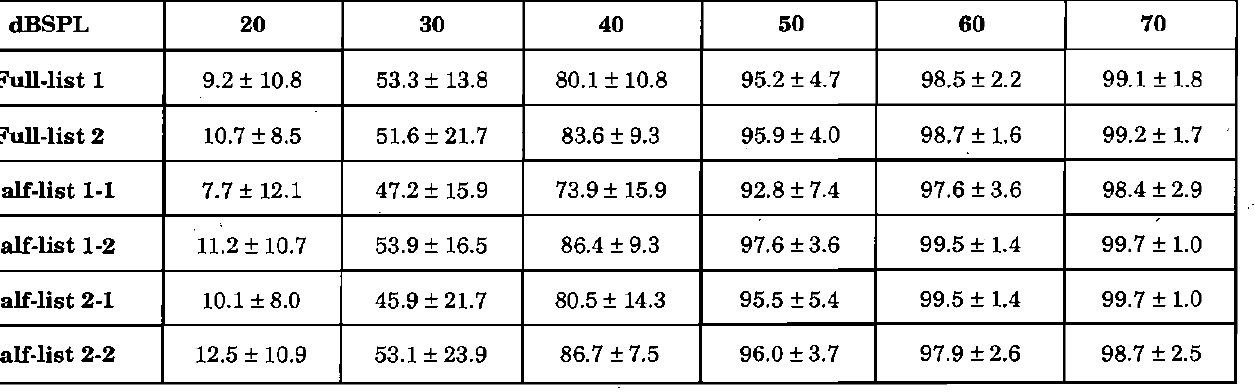
TABLE 1: South African English speakers' mean +one S.D. speech discrimination scores on the Tygerberg CID W22 full-lists 1 and 2, and their respective half-lists 1-1,1-2, 2-1 and